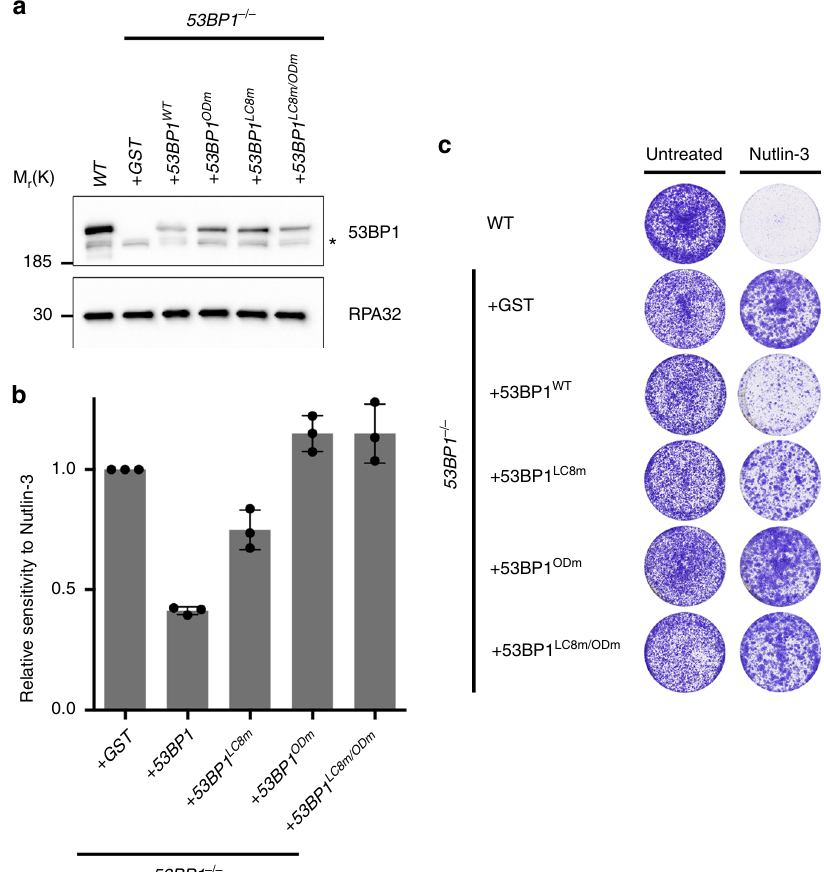
Fig. 5 DYNLL1 is required for 53BP1-dependent p53 responses to Nutlin-3. a Immunoblot analysis of the MCF-7 cell lines used in ( a ) with anti-53BP1 or anti-RPA32 antibodies prior to N3 treatment. b Quanti fi cation of n = 3 independent experiments represented in ( a ), each performed in triplicate. Mean ± SD. c Indicated parental or stably complemented 53BP1 -/- MCF-7 cell lines were incubated in the presence (11 days) or absence (7 days) of Nutlin-3 (4 µ